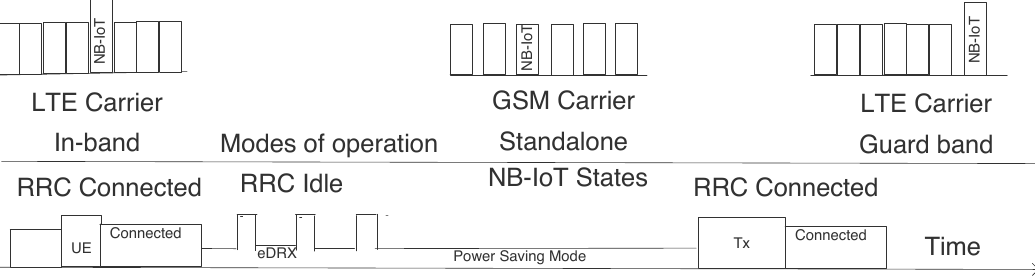
Figure 18. NB-IoT states and modes of operation.